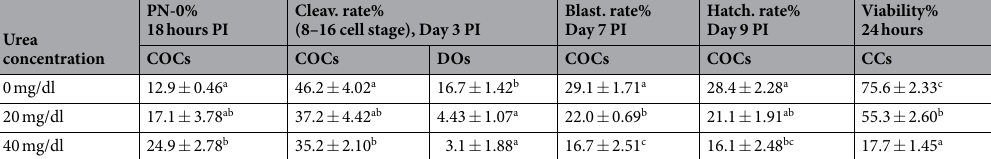
(Table 1). In the biplot, the first two principal components explained 82.2% of the variance, 63.2% from PC1